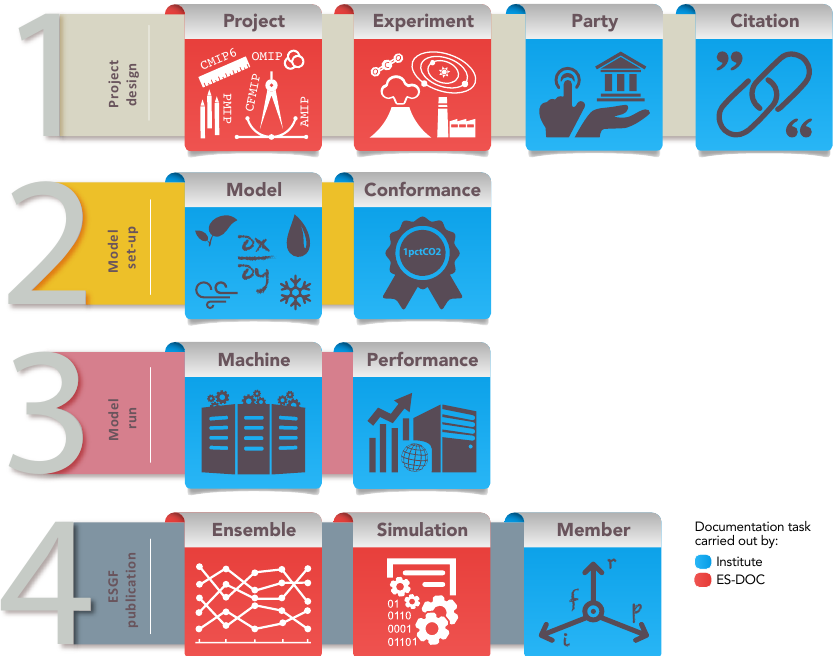
Figure 6. Elements of ES-DOC documentation. Rows indicate phases of the modelling process being documented, and box colours indicate the parties responsible for producing the documentation (see legend). Figure courtesy of Guillaume Levavasseur,